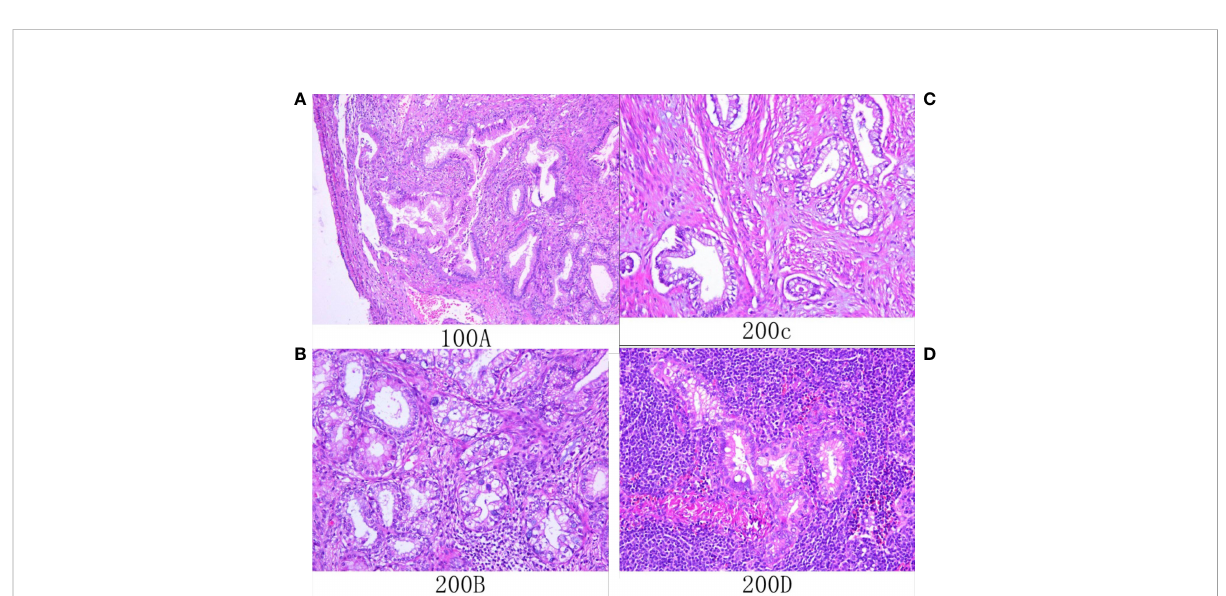
FIGURE 3 Isolated uterus after the